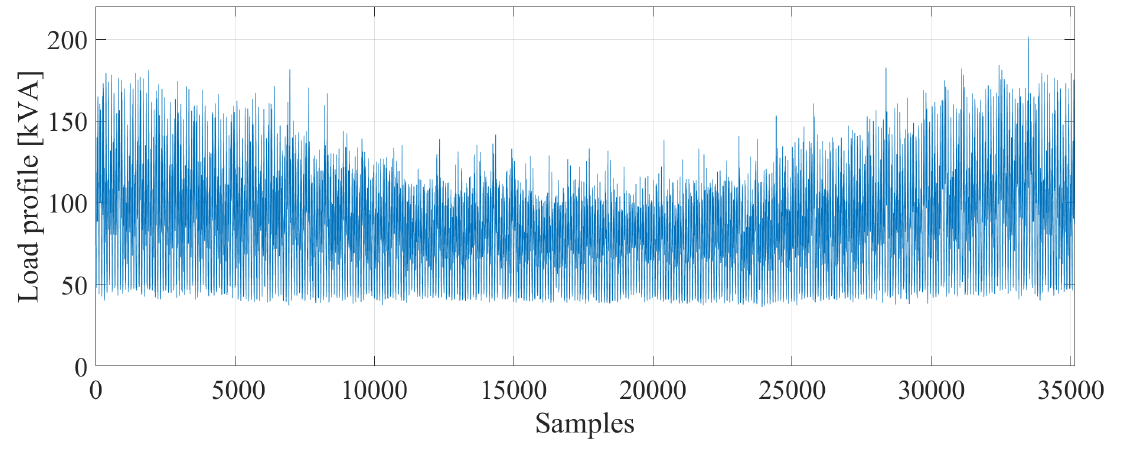
Figure 4. Aggregated load profile of all different single-phase load